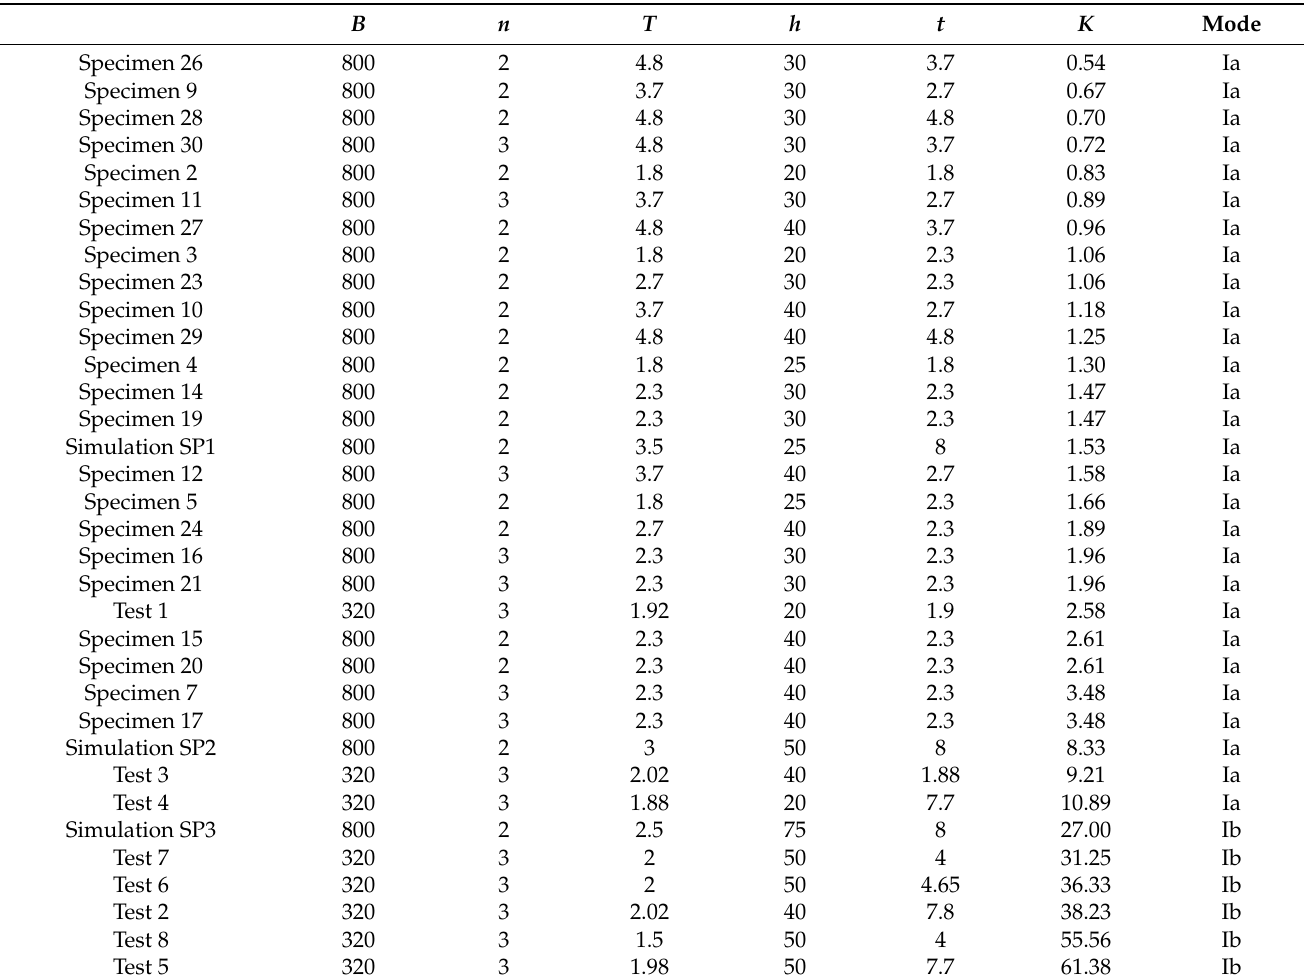
Table 4. Relative factors and final deformation